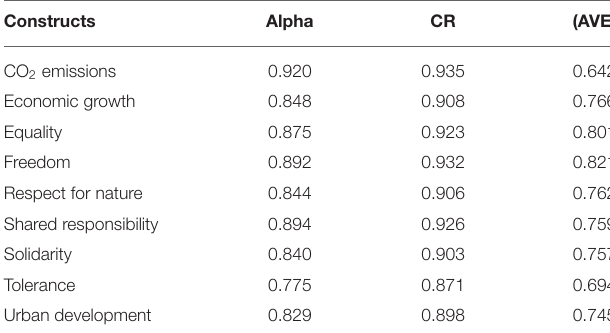
TABLE 2 | Reliability convergent validity analysis.